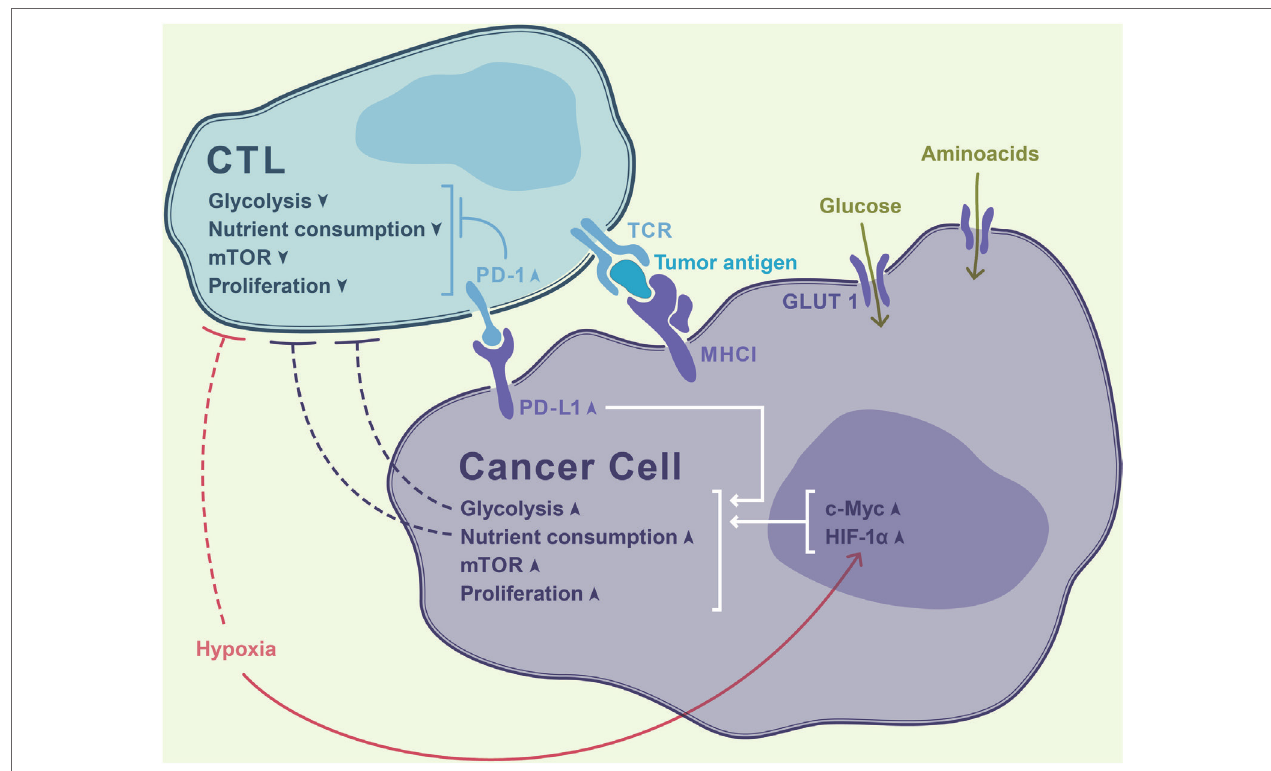
FigURe 1 | Rapidly proliferating tumor cells avidly consume nutrients from the microenvironment, thereby outcompeting T cells in a contest for metabolic fitness. Increased activity of hypoxia-inducible factor-1 α (HIF-1 α ) driven by tumor hypoxia further intensifies glycolysis and exacerbates the paucity of glucose in the milieu. This results in T cell deprivation of essential fuel for their effector function, resulting in a thwarted antitumor immune response. PD-1 signaling in T cells dampens their glycolytic activity and proliferation, while PD-1 ligand (PD-L1) ligation leads to opposite effects in cancer